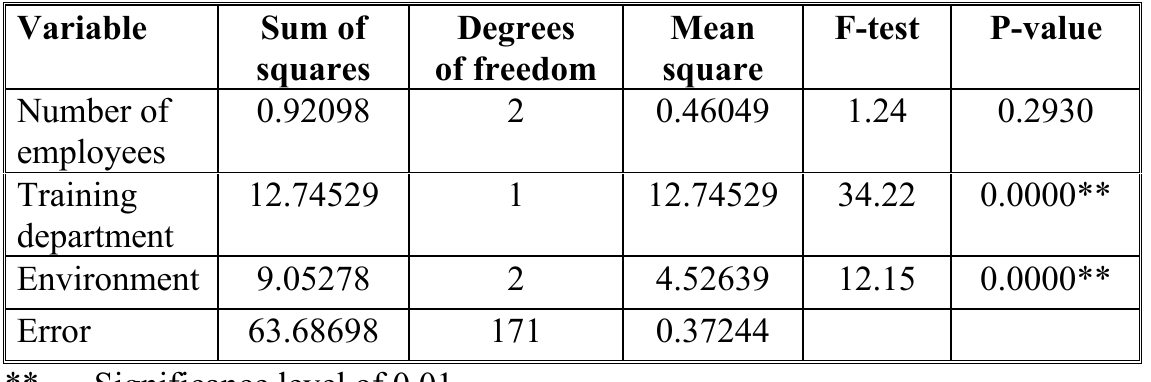
Table 6 shows the ANOVA results which investigate the